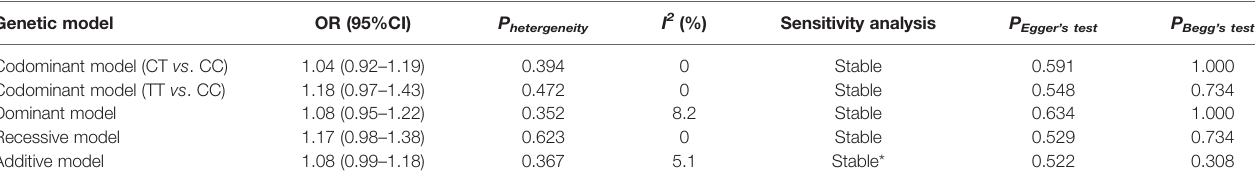
TABLE 4 | Meta-analysis of the association between MBOAT7-TMC4 rs641738 and HCC risk under other genetic models. Genetic model Codominant model (CT vs .